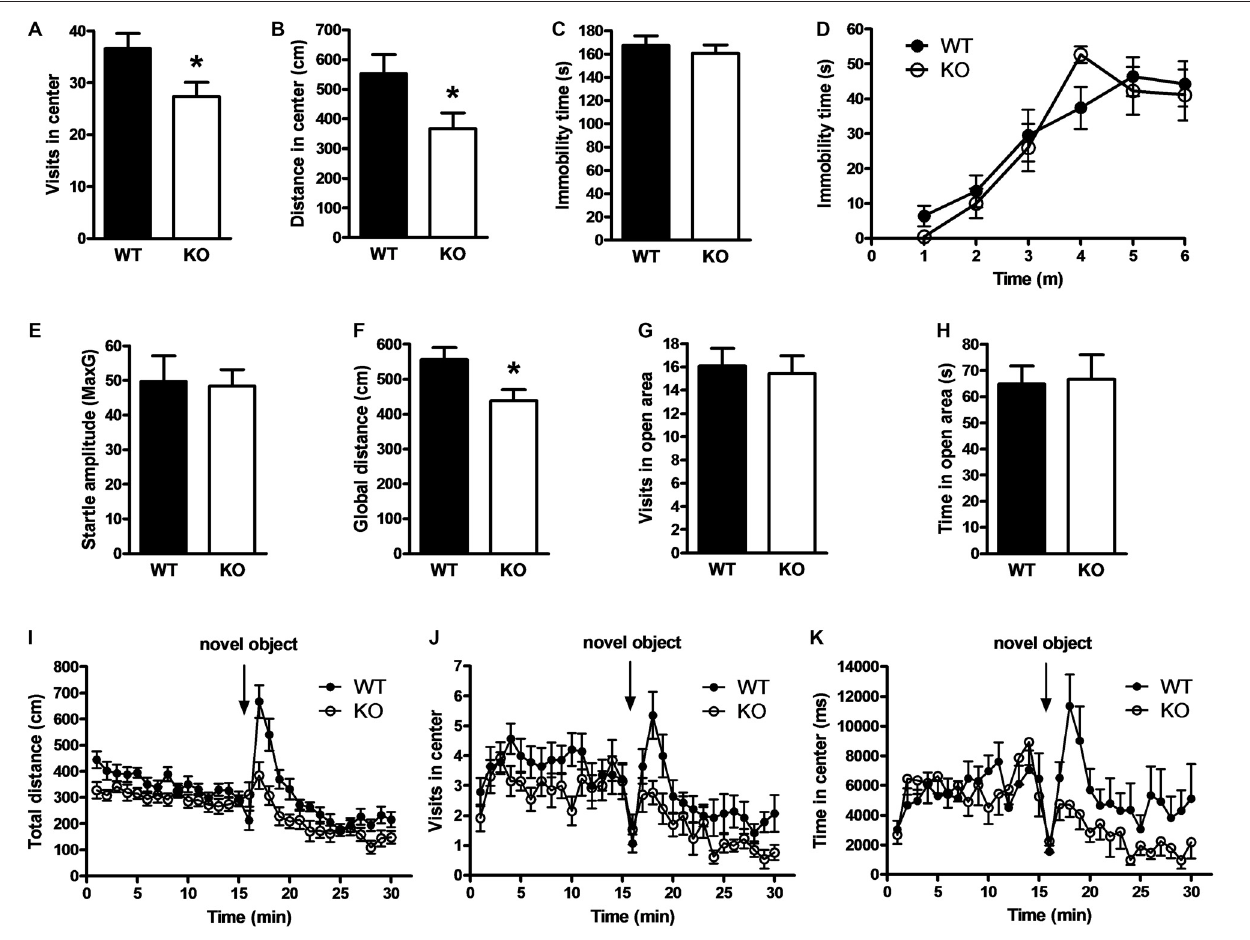
FIGURE 6 | Effects of PROT deletion on emotional behavior in PROT − / − mice. (A) Locomotor activity analyses in the central part of the open-field for 15 min displayed reduced number of entries for PROT − / − (KO) mice ( n = 52) compared with WT animals ( n = 56). (B) Similar analyses revealed diminished distance traveled in the center for the KO ( n = 39) in contrast to WT ( n = 42). (C,D) Behavior of WT and KO mice in behavioral despair models of depression; both in the tail suspension test (C) and the forced-swimming test (D) WT ( n = 10) and KO ( n = 7) animals spent similar time immobile. (E) Startle response test for characterization of anxiety-related behavior; the basal startle amplitude in KO mice was comparable to that of WT ( n = 10 mice for each genotype). (F–H) Zero-maze test; KO mice ( n = 17) showed diminished locomotor activity compared with WT ( n = 14) animals (F) during the 5 min trial, but no alterations in the number of entries (G) and time spent (H) into the open sector. (I–K) PROT KO mice display reduced locomotor responses to a novel object; KO ( n = 13) exhibited decreased locomotor activity in response to a novel object (I) , performed less entries (J) , and spent less time (K) in the proximity of the novel object compared with WT ( n = 14). Data are depicted as means ± SEM. ∗ p < 0.05; two-tailed Student’s t